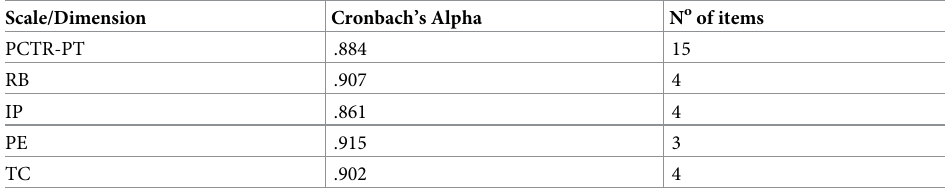
Table 5. Reliability statistics of the PCTR-PT (n = 366).